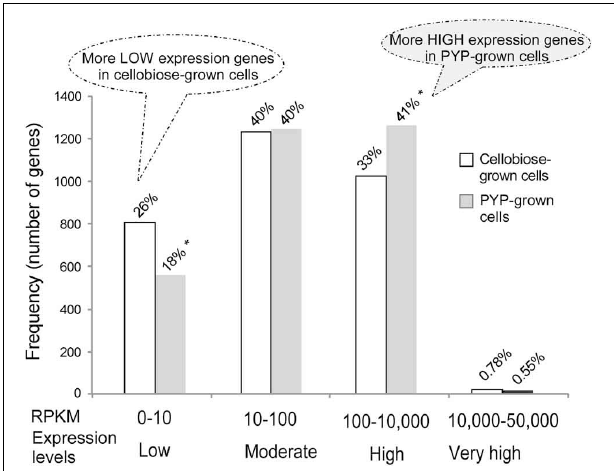
FIGURE 3 | RPKM frequency histogram of transcripts from RNA-Seq of pretreated yellow poplar (PYP)- vs. cellobiose-grown C. thermocellum cells. The diagram shows the distribution of the number of genes expressed at different RPKM levels. The total number of protein coding genes aligned with the RNA-Seq was 3081; the percentage value above each bar indicates the genes at specific expression level accounting for the proportion of total number of genes. The ∗ mark indicates that significantly different frequencies (i.e., numbers of genes) were observed between the two RNA-Seq data sets from PYP- vs. cellobiose-grown C. thermocellum